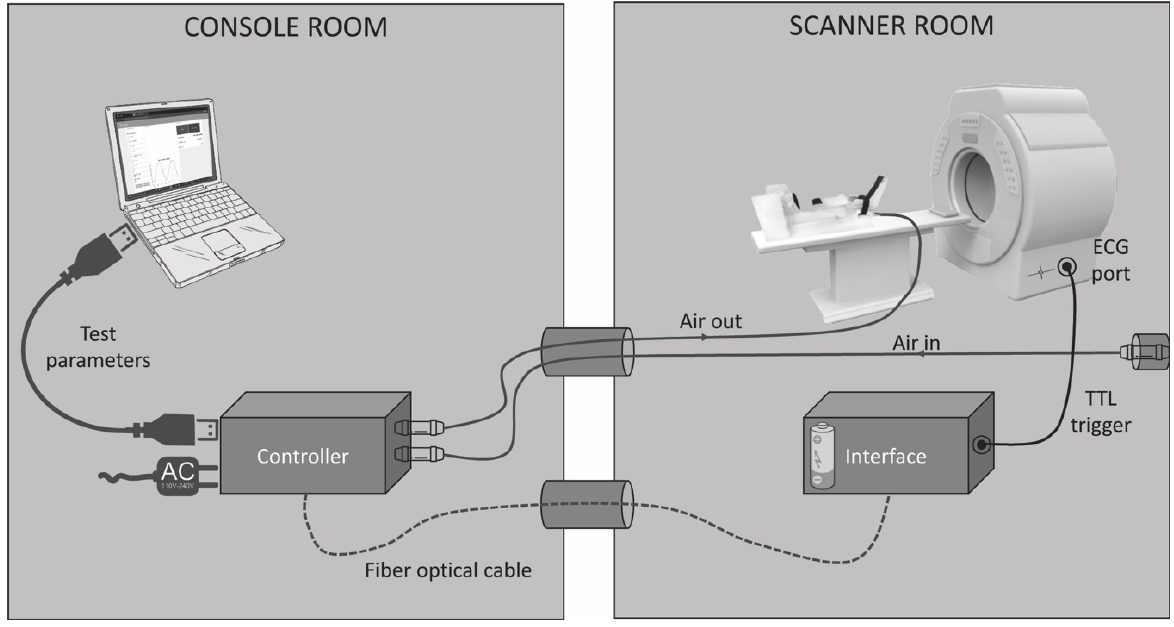
Figure 2. Experimental setup.